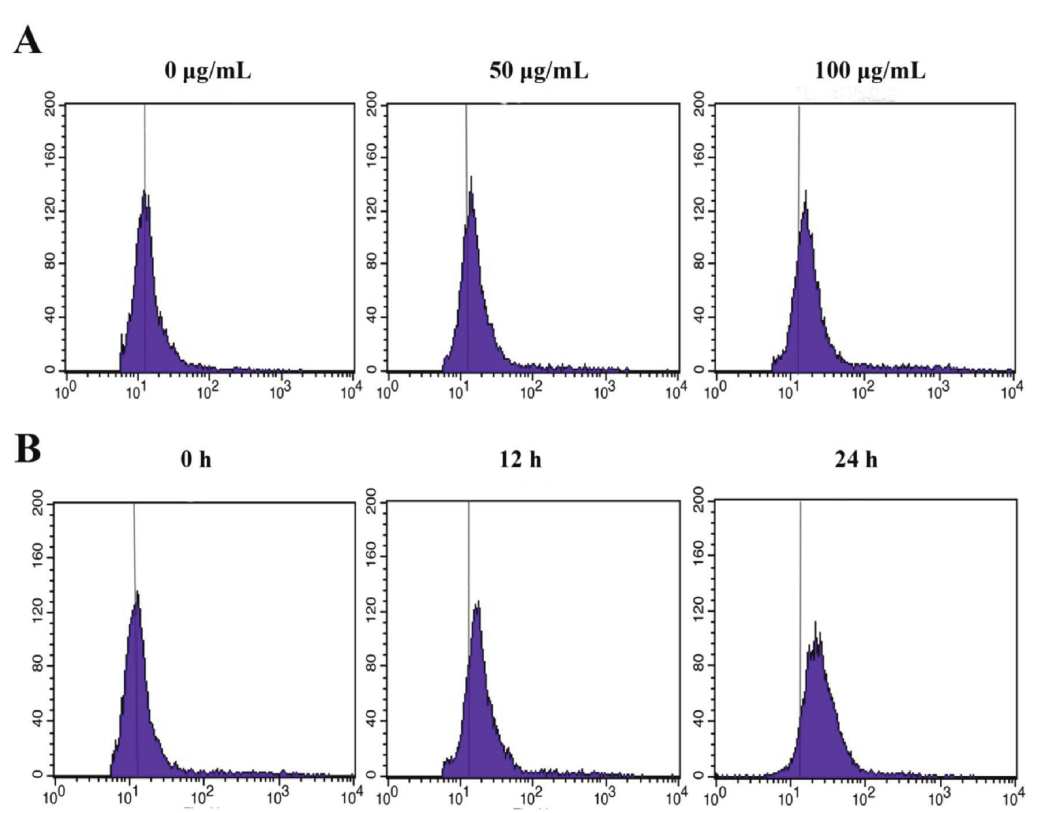
FIGURE 4 - The changes in the accumulation of ROS. (A) EEEO induced increase of ROS in dose-dependent manners. (B) HepG2 cells were treated with 50 μg/mL EEEO for 0 h, 12 h and 24 h.